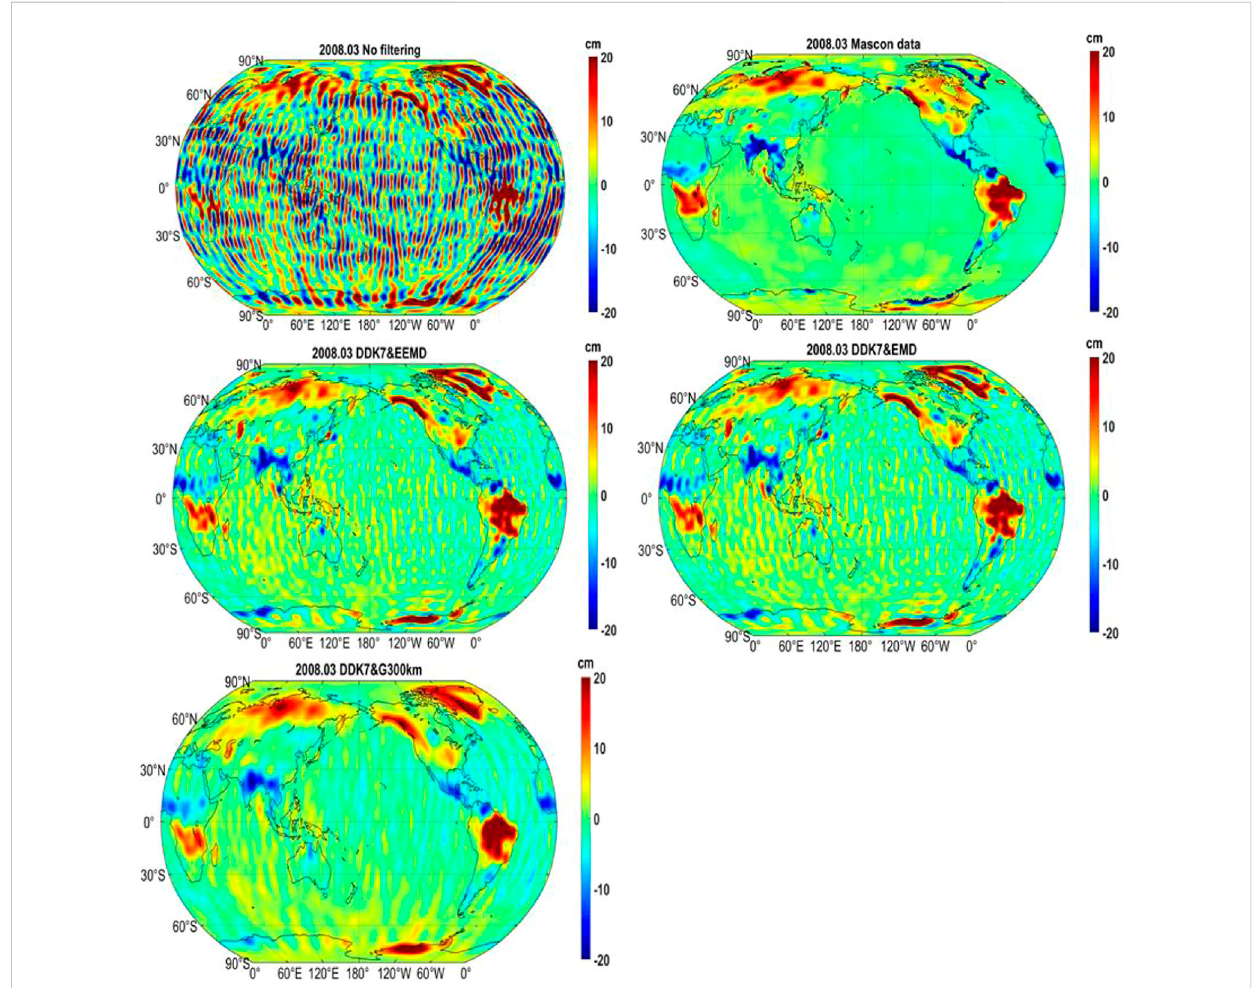
FIGURE 10 Global mass changes extracted by EEMD, EMD, Gaussian smoothing 300 km (G300 km) approaches together with DDK7 fi lter in March 2008.